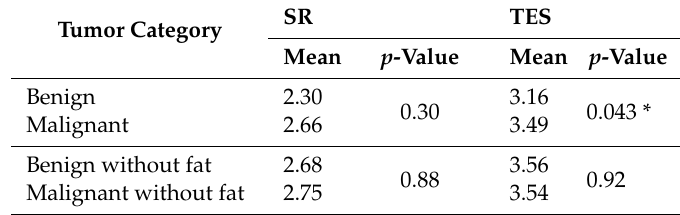
Table 2. Mean strain ratio (SR) and TES.